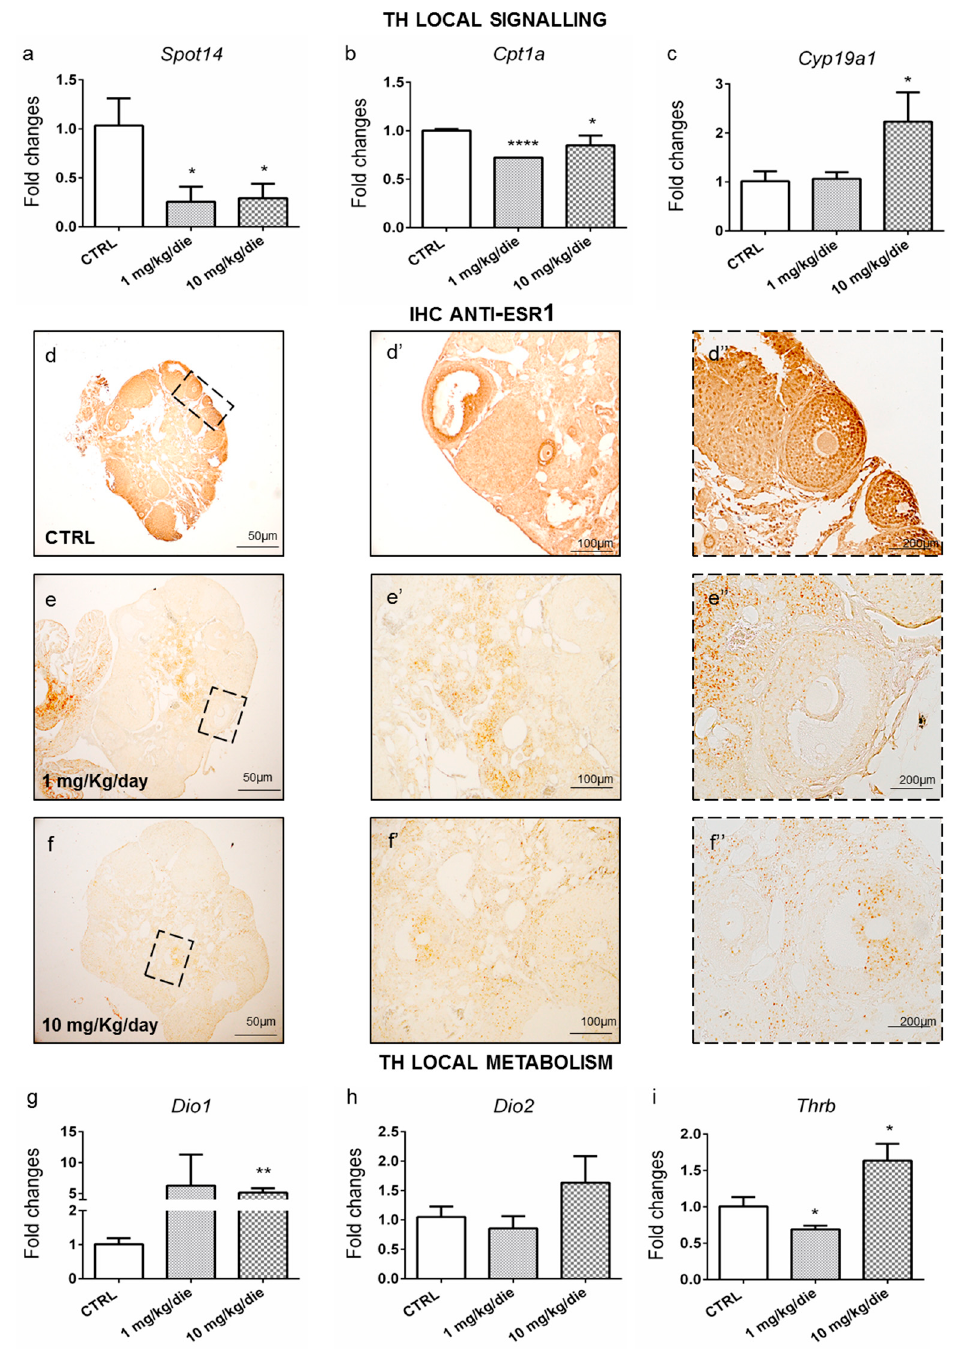
Figure 5. Mice developmentally and long-life exposed to CPF exhibit ovarian TH signaling and metabolism alterations. ( a – c ) RT-qPCR analysis of the levels of T3 responsive transcripts ( Spot14 , Cpt1a , and Cyp19a1). ( d – f” ) Staining for Esr1 on mice ovaries sections (5 × , 10 × , 20 × magnification), showing the alteration of Esr1 level in exposed groups ( n = 3 ovaries/group). ( d – d” ) Staining in CTRL groups. ( e – e” ) Staining in exposed group to 1 mg/kg/day. ( f – f” ) Staining in exposed group to 10 mg/Kg/day ( g – i ) TH inactivation and activation enzymes ( Dio1 and Dio2) and Thrb receptor expression were analyzed by RT-qPCR ( n = 5 ovaries/group). Data are reported as fold change values calculated as a ratio between average relative gene expression in exposed and control ovaries after normalization on β -actin mRNA. Significant differences are indicated with * p < 0.05, ** p < 0.01 and **** p < 0.0001 using Student’s t